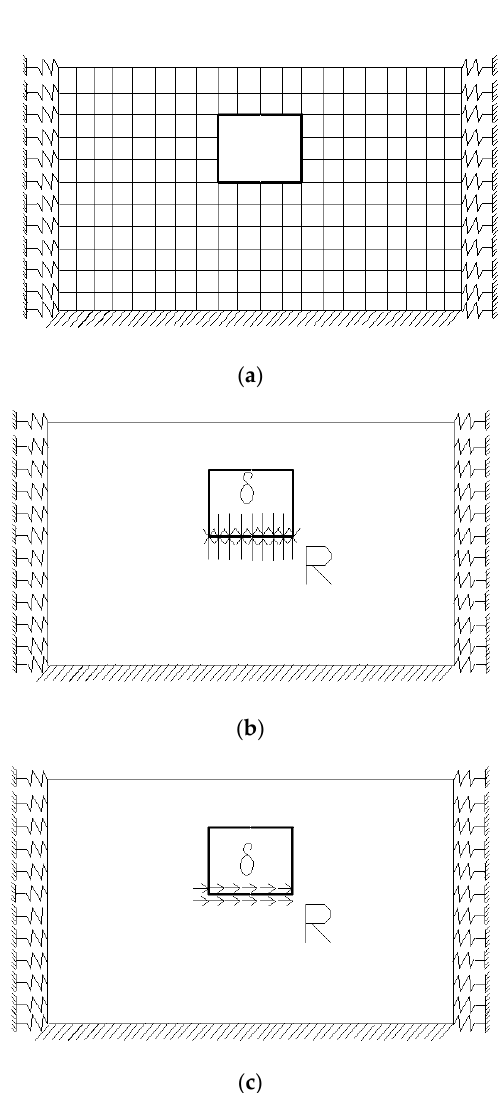
Figure 4. Finite element calculation model of reaction spring parameters of underground structure foundation. ( a ) Meshed model, ( b ) normal spring stiffness calculation model, ( c ) tangential spring stiffness calculation model.